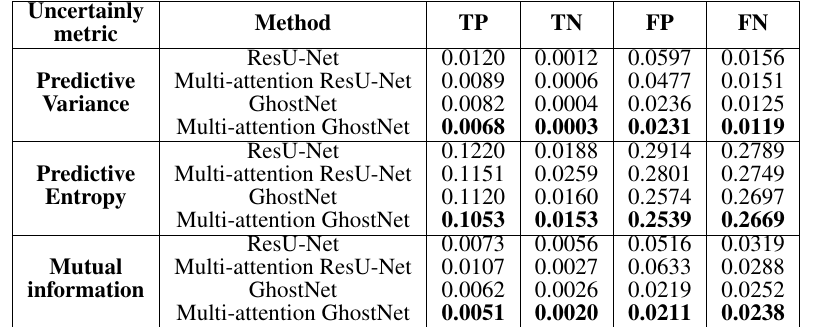
Table 4. Uncertainly metrics for True Positives (TP), True Negatives (TN), False Positives (FP), and False Negatives (FN) computed with the average predictions of the four methods.